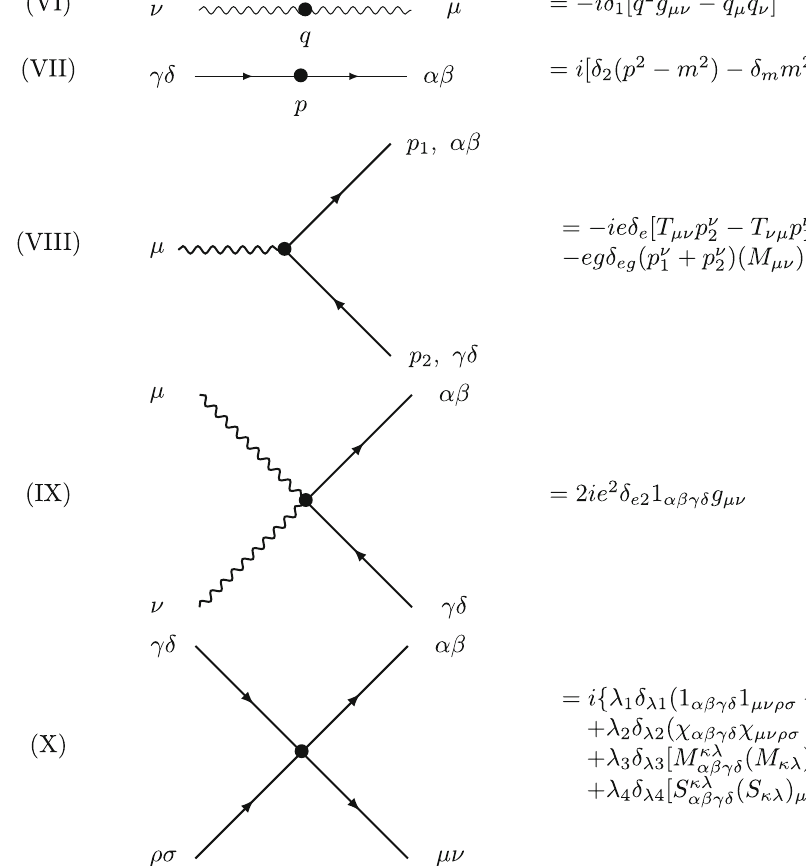
Fig. 2 Feynman rules for the counterterms Fig. 3 Feynman diagrams for the vacuum polarization at one-loop